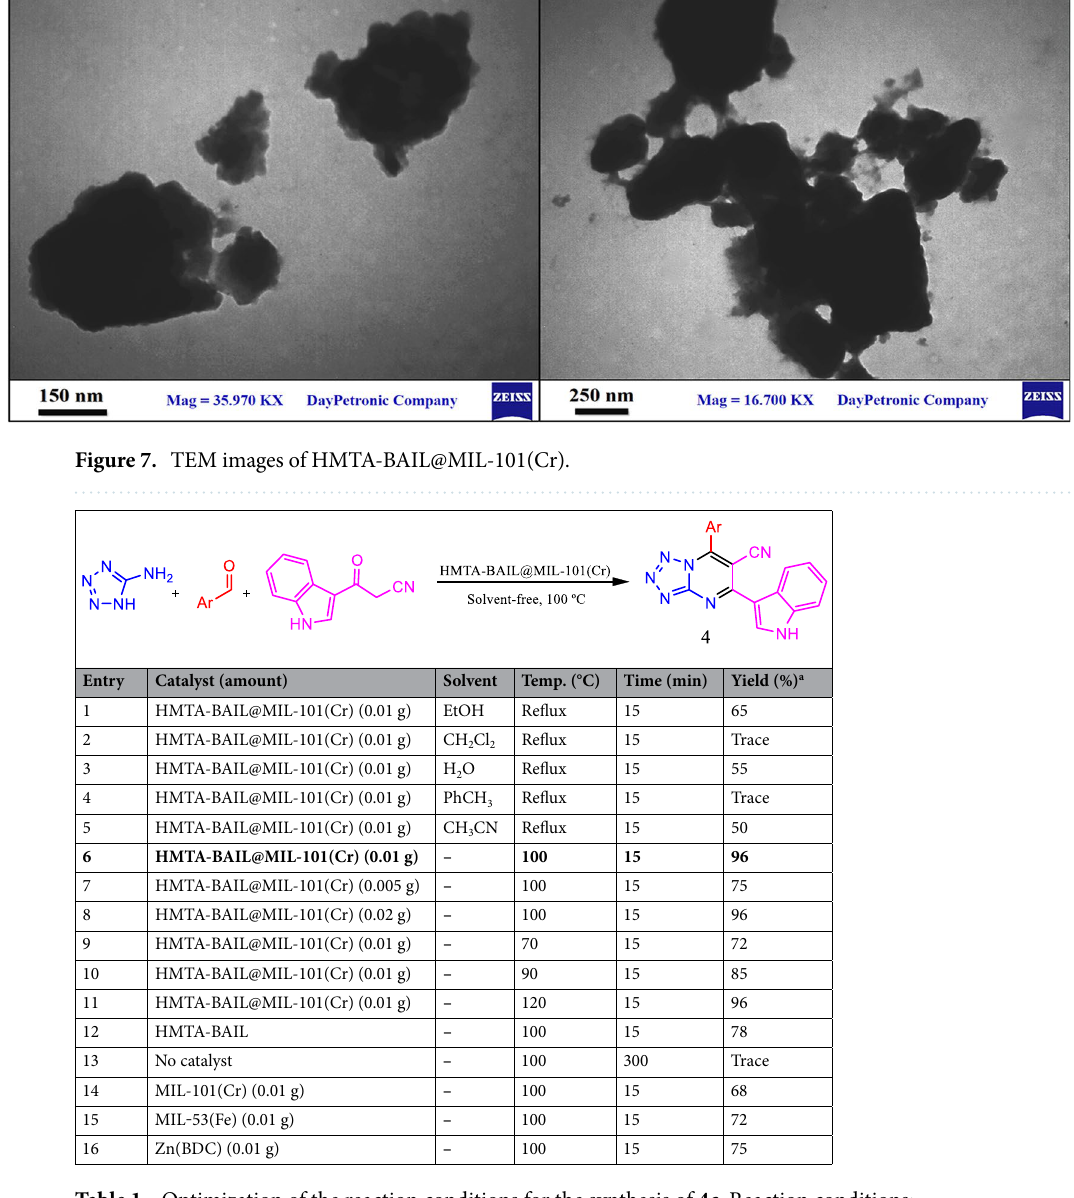
Table 1. Optimization of the reaction conditions for the synthesis of 4c . Reaction conditions: 4-bromobenzaldehyde (1 mmol), 1 H -tetrazole-5-amine (1 mmol), and 3-cyanoacetyl indole (1 mmol). No by-products detected in 1 H NMR spectrum of the crude reaction mixtures. a Isolated